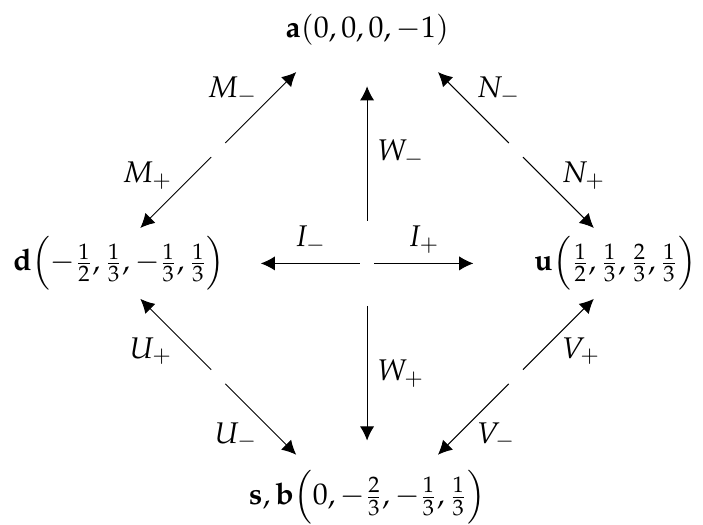
Figure 1. Simplest irreducible non-trivial representation of the SU ( 4 )